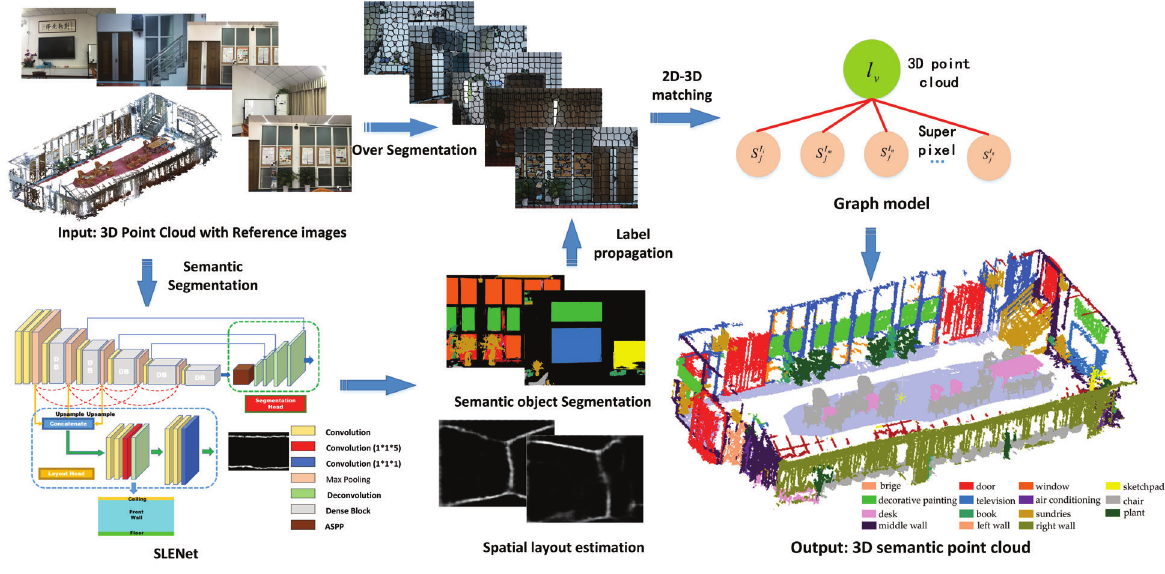
Figure 1. The framework of labeling transfer from 2D images to 3D point clouds